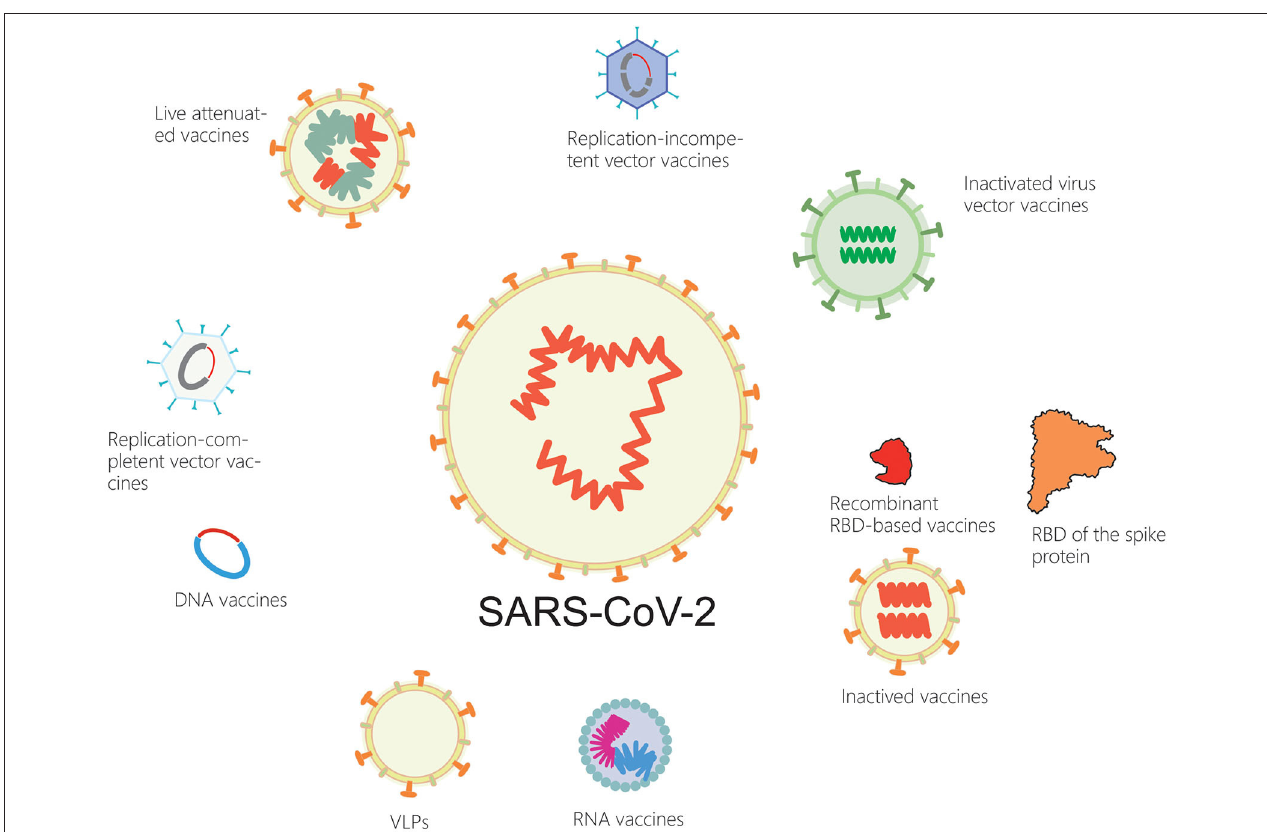
FIGURE 1 | Current SARS-CoV-2